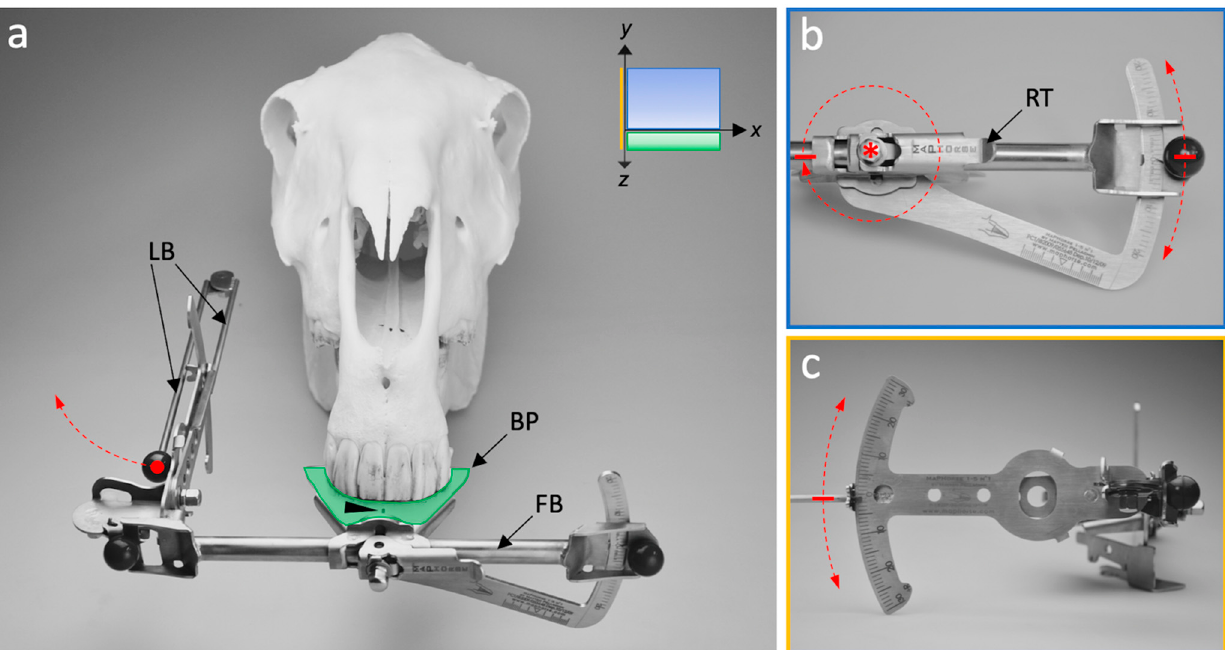
Figure 2. Main mechanical components of the MaPHorse1 . ( a ) Dorso-rostral view; the bite plate (BP) is positioned between incisor arcades. The central marking line (arrowhead) is aligned to the interdental space of central incisors 101 and 201. The lateral bar (LB) can be folded. FB, frontal bar. ( b ) Frontal view of the TA protractor. Retainer (RT) preventing free FB movement around a rotational connection (asterisk) with the BP; induced movement is possible. FB moves in a transversal plane ( xy ). ( c ) Lateral view of the SA protractor. LB moves in a sagittal plane ( yz